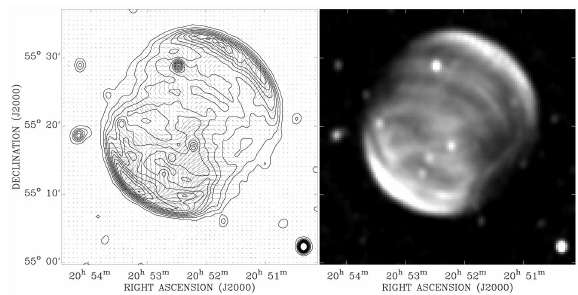
Figure 1: Radio continuum emission from SNR DA 530 (1420 MHz) in contour representation (left) and gray scale (right). Vectors in the left image show the polarized intensity by their length and the direction of the E-field by their orientation (Landecker et al.,